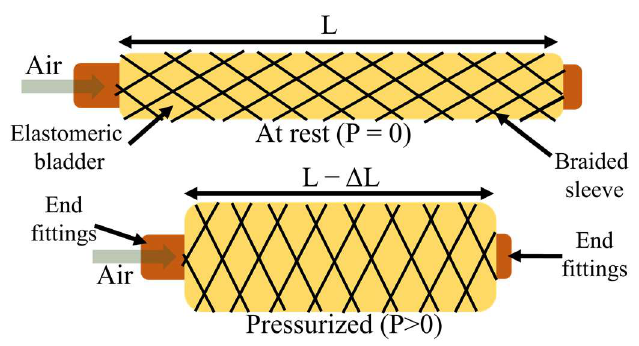
Figure 1. The working mechanism of thin McKibben pneumatic artificial muscles.